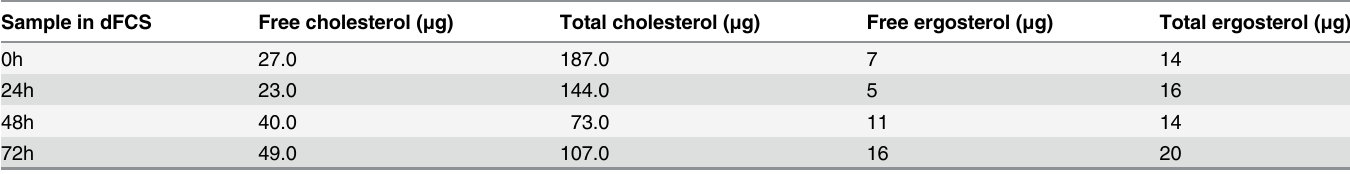
All samples correspond to 5 μ g/mL of